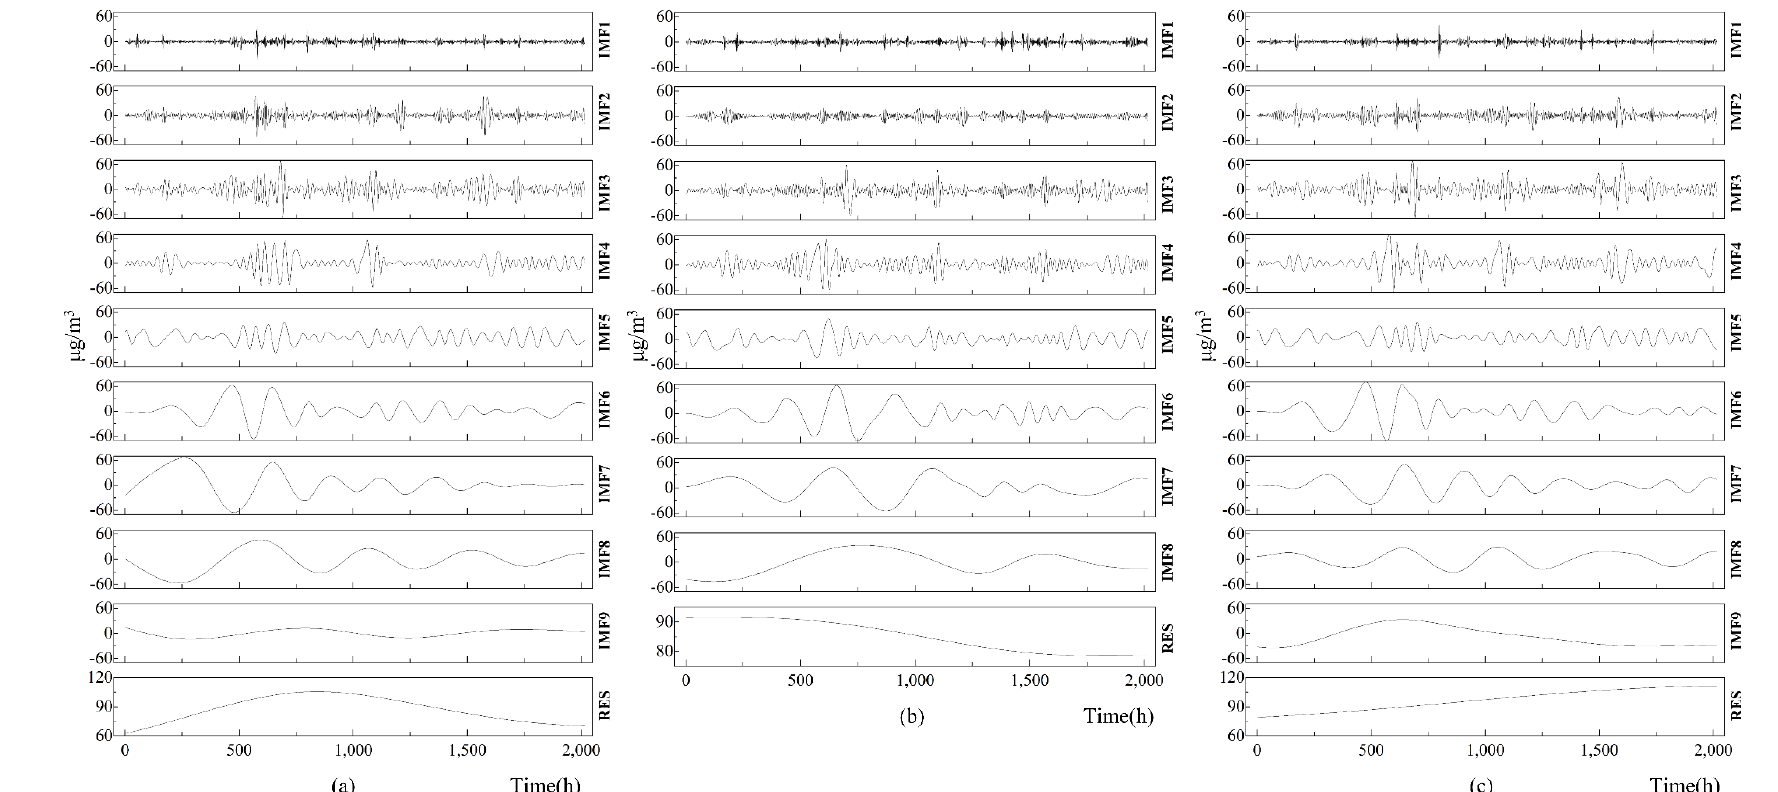
Figure 4. IMFs and residuals of the PM 10 concentration data series measured at ( a ) Site 1, ( b ) Site 2, and ( c ) Site 3.